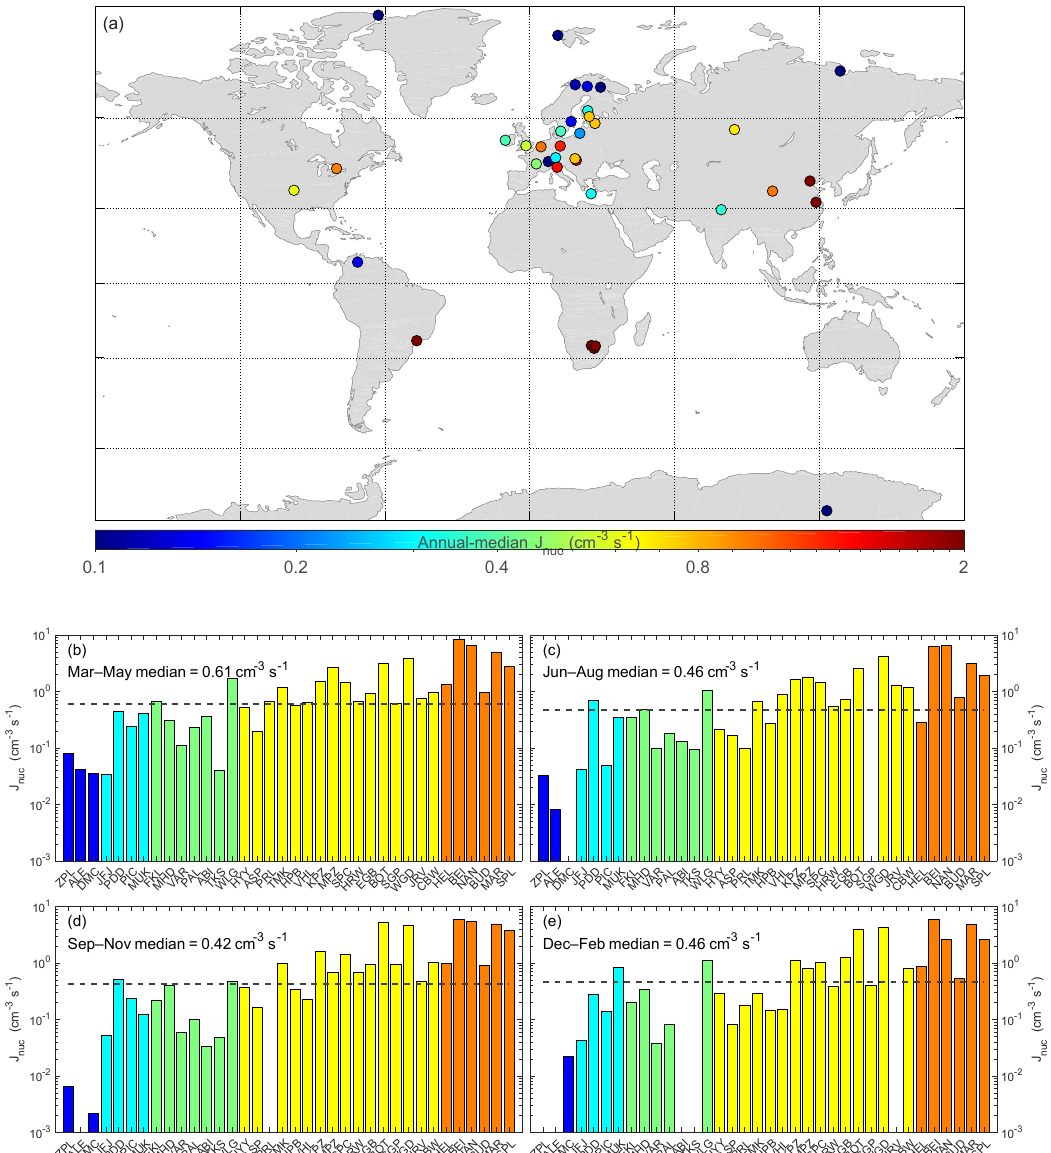
Figure 4. Annual-median (a) and seasonal-median (b–e) particle formation rate at the different measurement sites. The dashed lines in panels (b–e) show the median seasonal values, and the color scheme represents the classification of the sites into polar, high-altitude, remote, rural, and urban